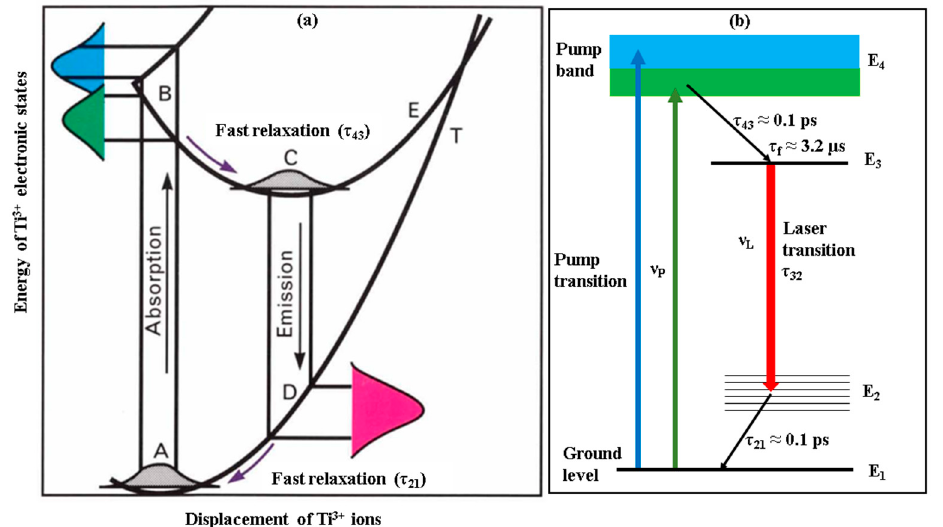
Figure 6. The Ti:Al 2 O 3 configurational diagrams. ( a ) The displacement domain band-structure of the upper and lower laser levels of the Ti:sapphire crystal. ( b ) Simplified energy level diagram of the Ti:sapphire four-level laser.